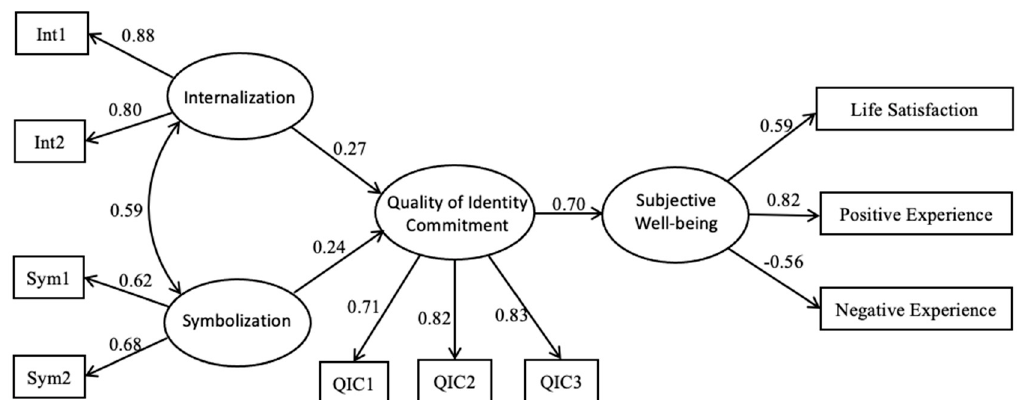
Figure 2. The final mediation model. Note: Factor loadings are standardized. Int1 and Int2 are two parcels of internalization; Sym1 and Sym2 are two parcels of symbolization; QIC1, QIC2 and QIC3 are three parcels of quality of identity commitment; All the path coefficients are significant at the 0.05 level.